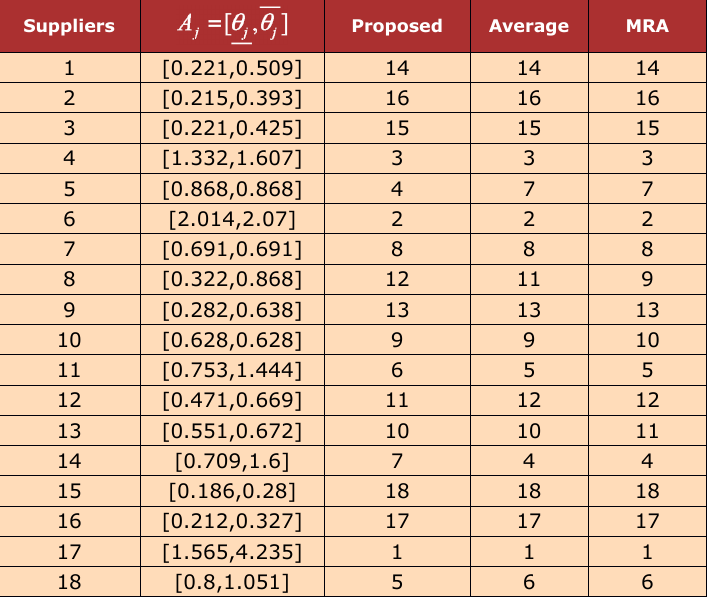
Table 10. The efficiency of suppliers and the ranking results